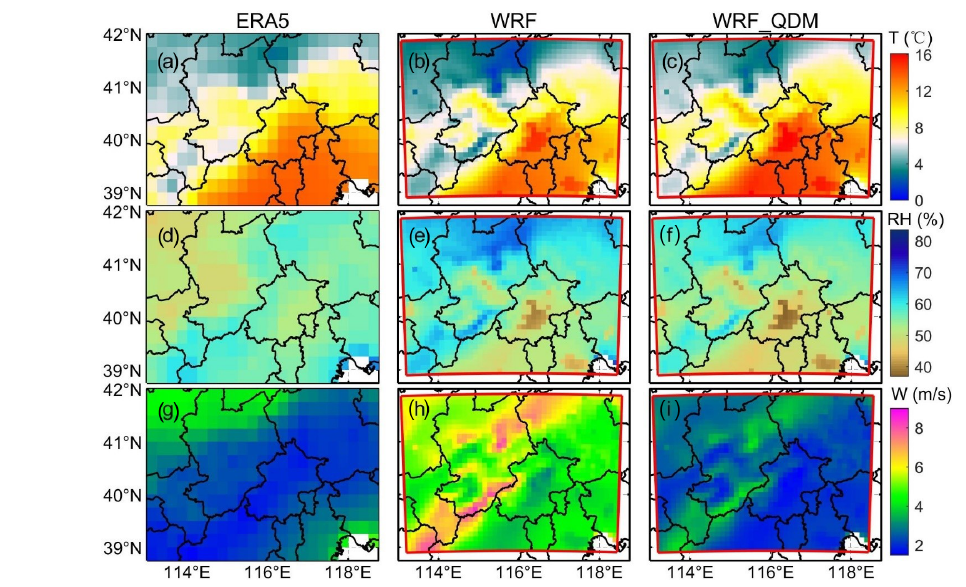
Figure 6. The spatial distribution of mean 2m temperature (a–c) , relative humidity (d–f) and 10m wind speed (g–i) from ERA5, WRF-ESM and WRF-QDM-ESM ensemble mean during 2008–2017. Figures S4–S6 show the four ESM results separately.